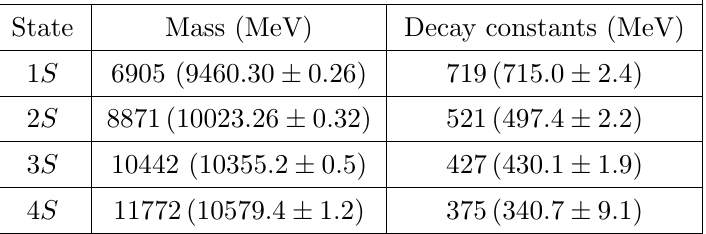
Table 1 . Holographic masses and decay constants for the bottomonium S -wave resonances. Ex- perimental values inside parentheses for